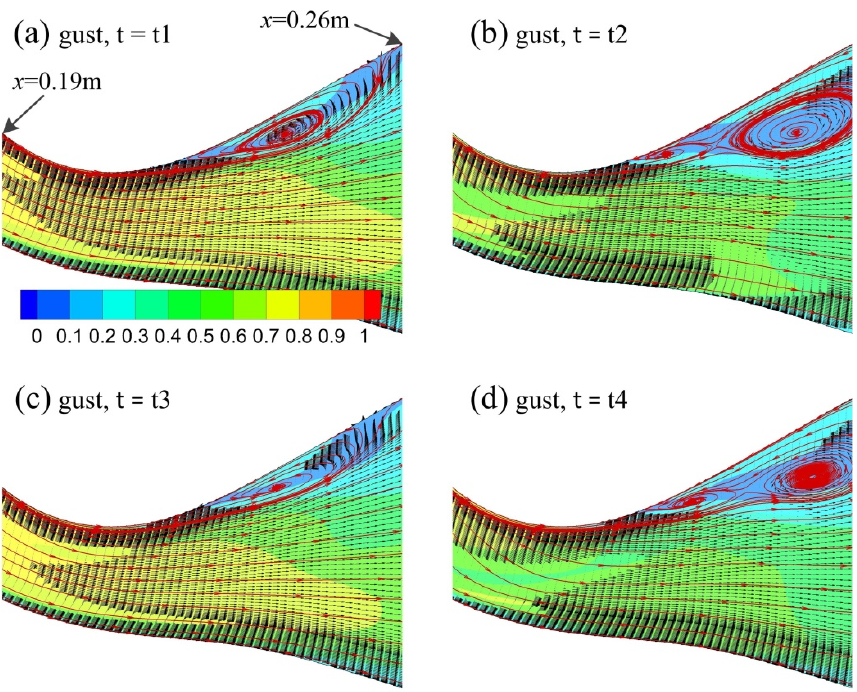
Figure 19. Velocity vector, streamline, and Mach number distribution near the flow separation zone for the gust case of f = 100 Hz and (cid:101) u g = 8 m/s at the four instants.